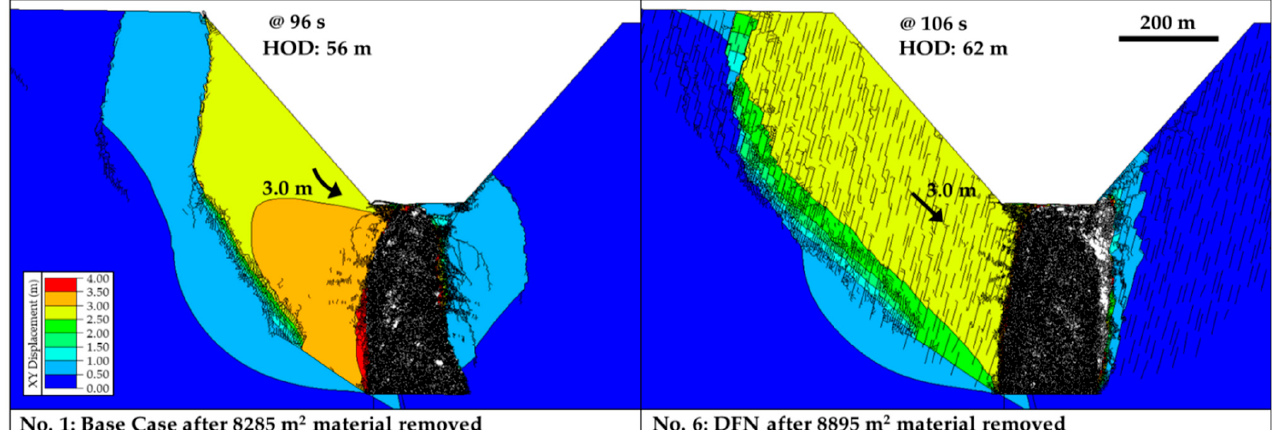
Figure 15. FDEM model results for models No. 1 and No. 6 with similar displacement in left pit wall. Maximum XY displacement contours.